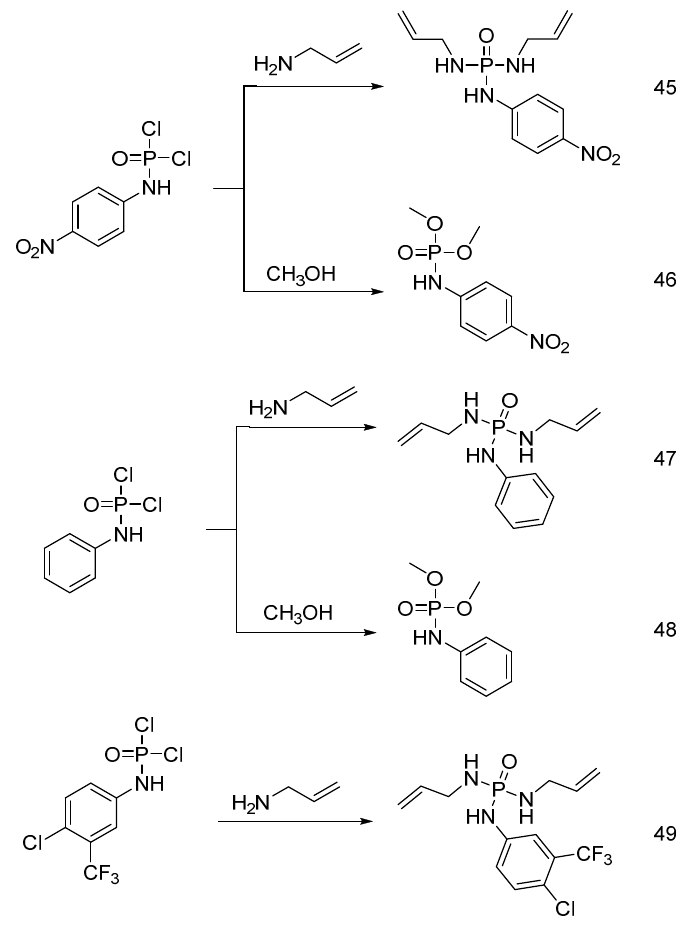
Figure 29. Representative synthesis of flame retardant additives ( 45 )–( 49 ).